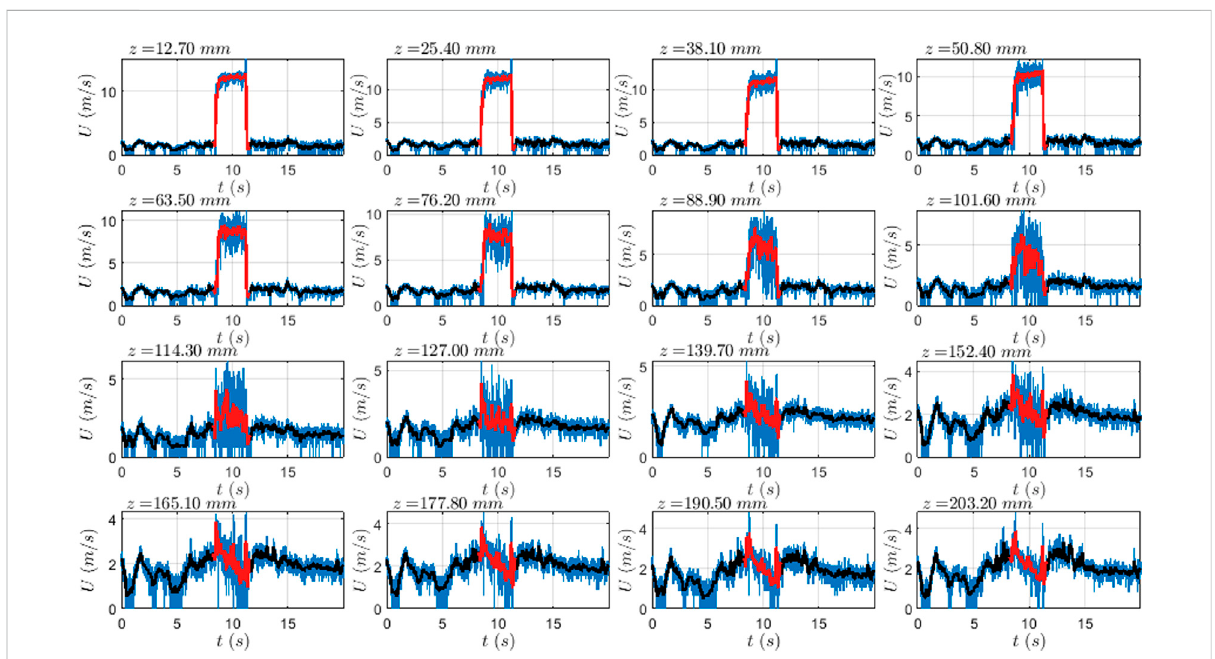
FIGURE 8 Downburst time history recorded at various heights using the 16 pitot tubes at the TTC using downburst simulator Option E in smooth